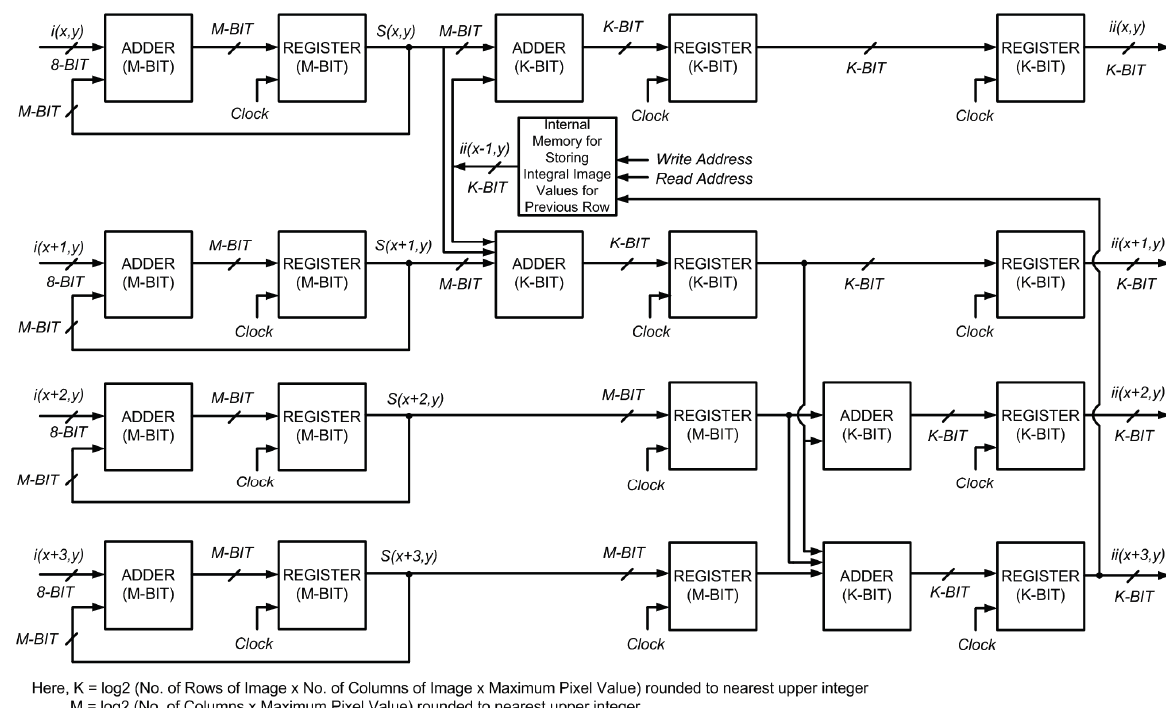
Figure 6. Block diagram of the proposed architecture for parallel computation of integral image for 4